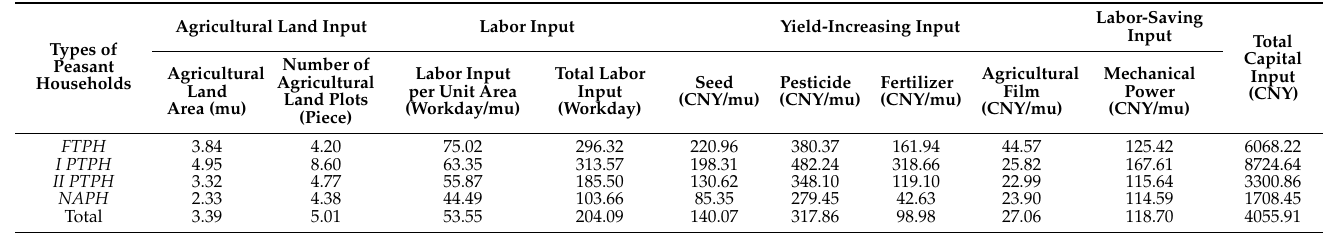
Table 4. Agricultural inputs of different types of peasant